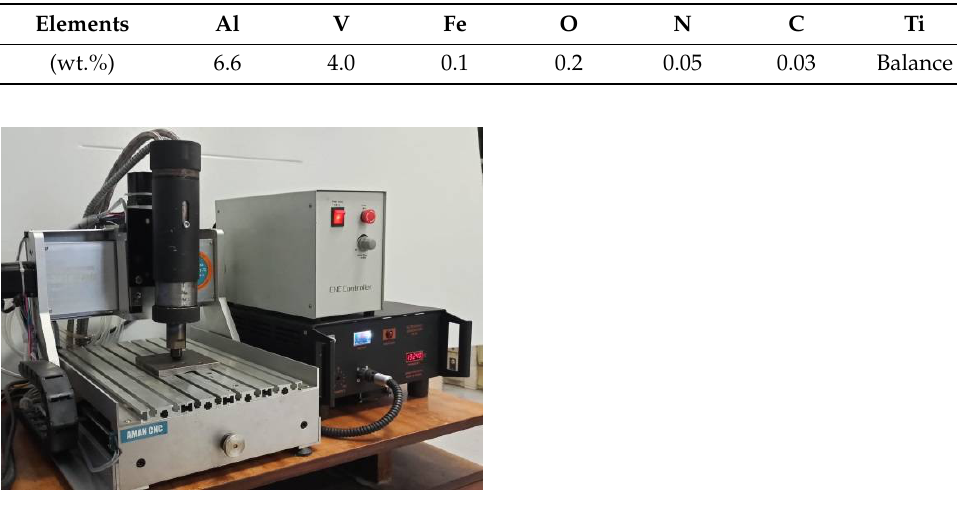
Figure 1. Picture of the designed automated UIT setup. Table 1. Chemical composition of Ti-6Al-4V titanium alloy.